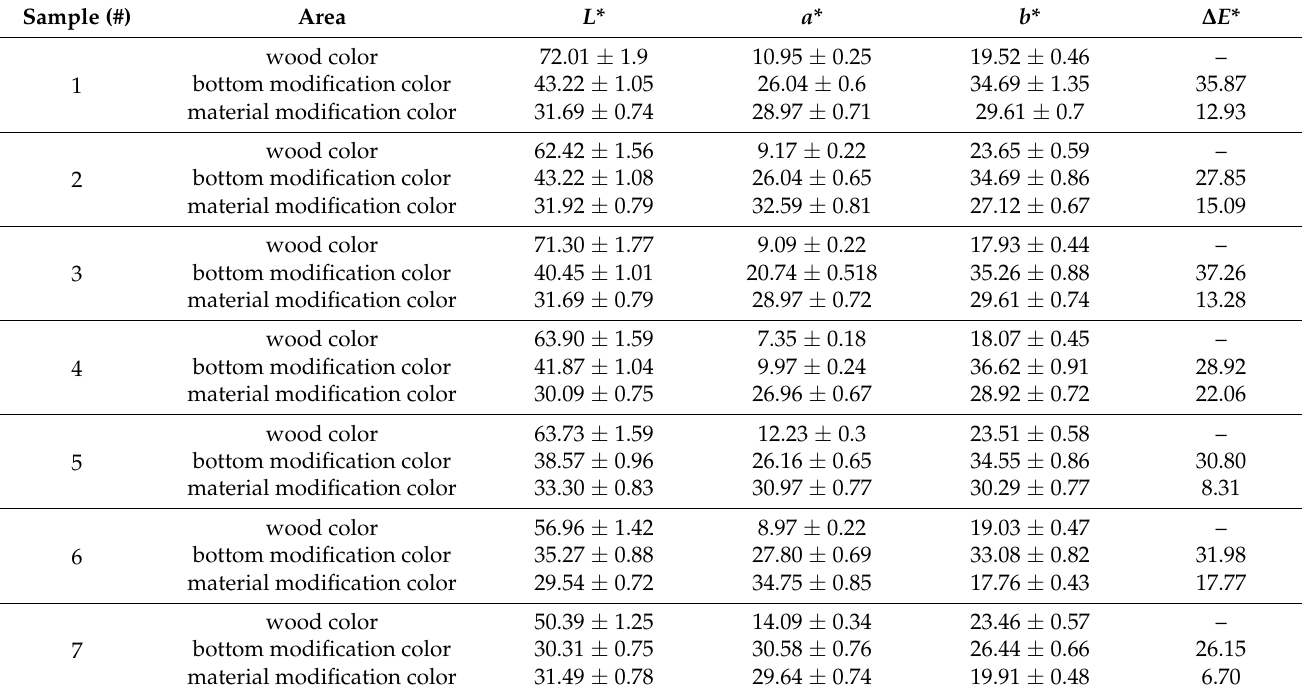
Table 3. Color measurement values for each area of the test piece.